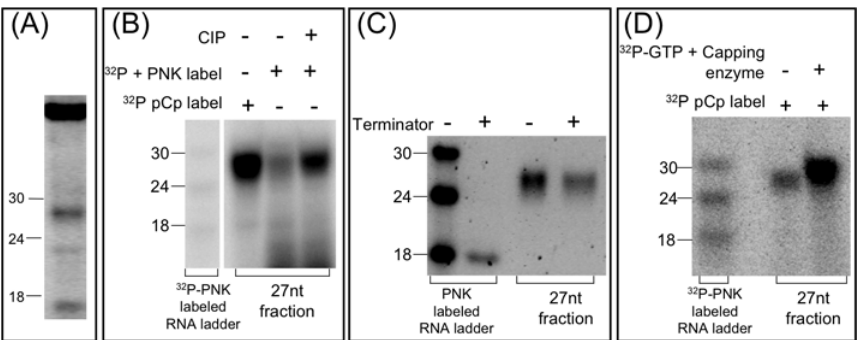
Figure 1. 27 nt small RNAs in Entamoebahistolytica trophozoites have 5 9 -polyphosphate termini. (A) Three endogenous small RNA populations ( , 27 nt, , 22 nt, and , 16 nt) can be detected in Entamoeba histolytica trophozoites by SYBR gold staining. The 27 nt population is the most abundant. (B) The 27 nt small RNA fraction can be labeled at the 3 9 -termini with a - 32 P pCp but does not label well with PNK (at the 5 9 -termini) unless the sample is first dephosphorylated by treatment with CIP. (C) A significant portion of the 27 nt small RNA fraction is resistant to cleavage by Terminator enzyme. The control (RNA ladder with a 5 9 -monophosphate) is degraded by Terminator enzyme. (D) The 27 nt small RNA fraction labels and increases in size when treated with 32 P-GTP + Capping enzyme, indicating that the 27 nt small RNAs have 5 9 di- or tri-phosphate termini.